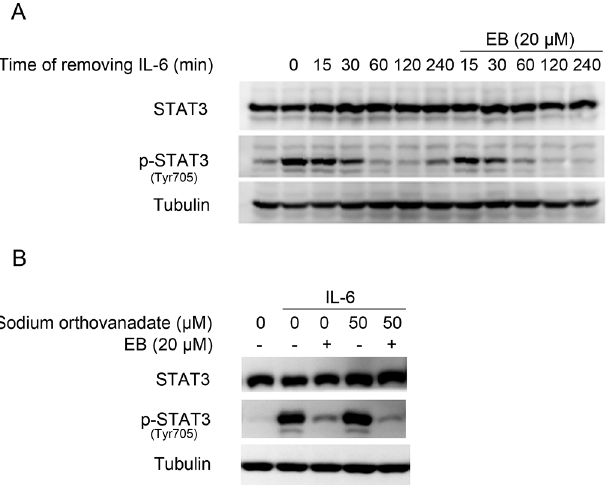
without EB (20 μ M) for different time periods (0 – 240 min). Whole cell lysates were processed for western blot analysis using antibodies as indicated. (B) A549 cells were pre-treated with sodium orthovanadate (50 μ